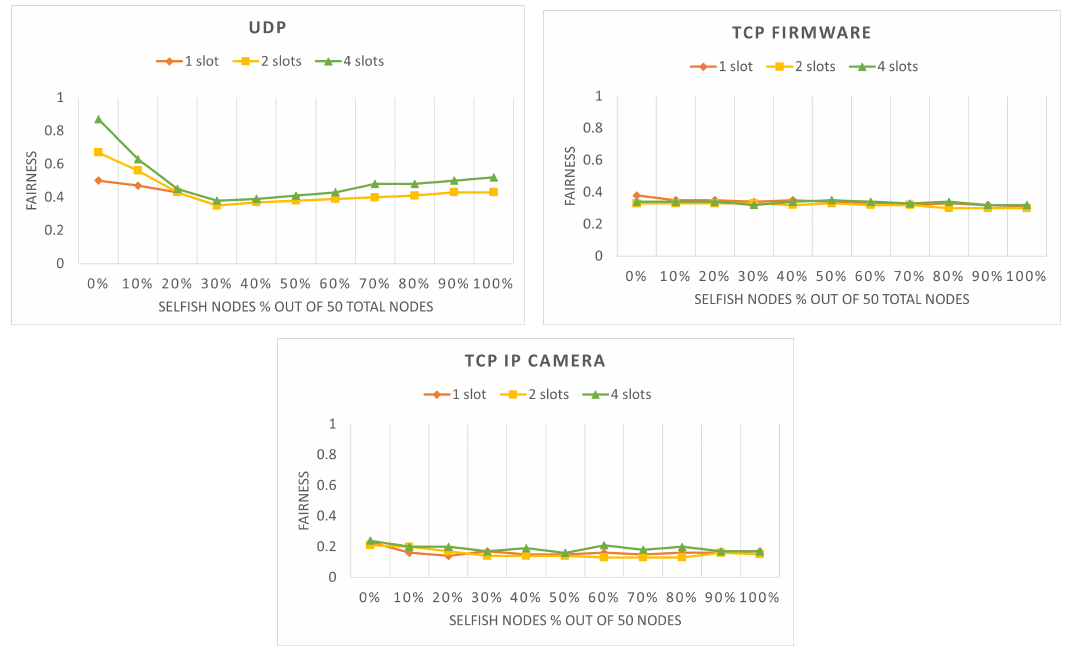
Figure 4. Network fairness with various percentage of selfish stations and RAW slots for 60